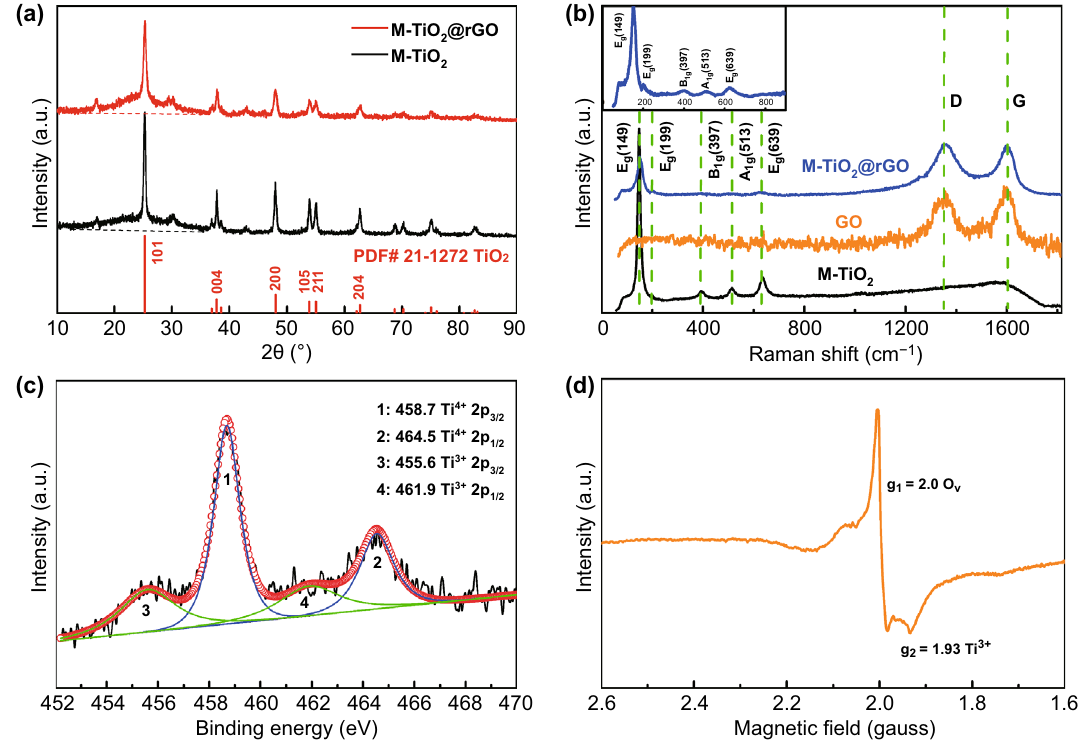
Fig. 3 Structure characterization of M‑TiO 2 @rGO composite. a XRD of M‑TiO 2 and M‑TiO 2 @rGO; b Raman of M‑TiO 2 , GO, and M‑TiO 2 @ rGO; c XPS curve of Ti 2p ; and d EPR curve of M‑TiO 2